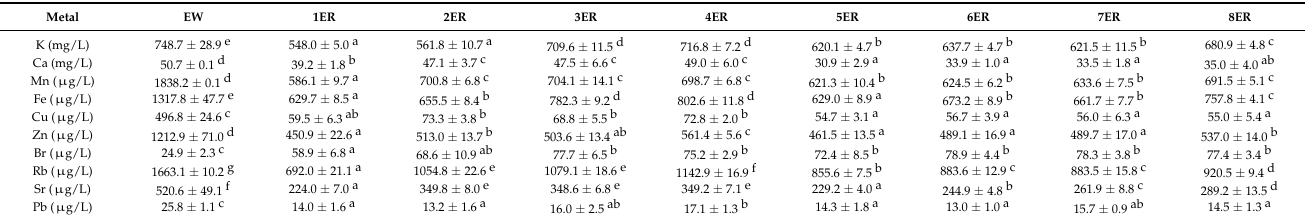
Table 8. Elements content in the initial ecological Cabernet Sauvignon wine and the retentates obtained by RO at 2.5, 3.5, 4.5 and 5.5 MPa, with cooling and without